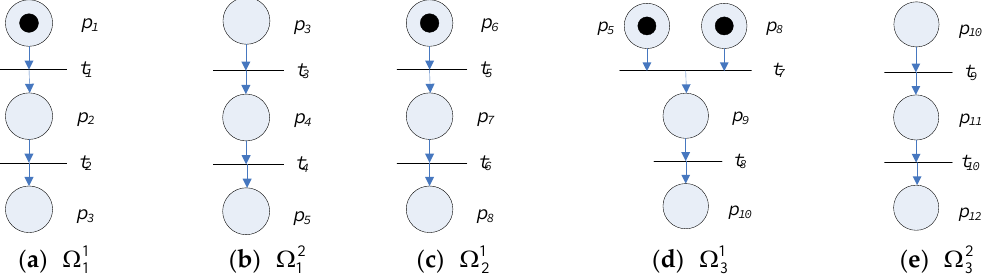
for operation o 1 ; ( b ) A DTPN model Ω 2 1 for operation o 4 ; I A DTPN model Ω 2 3